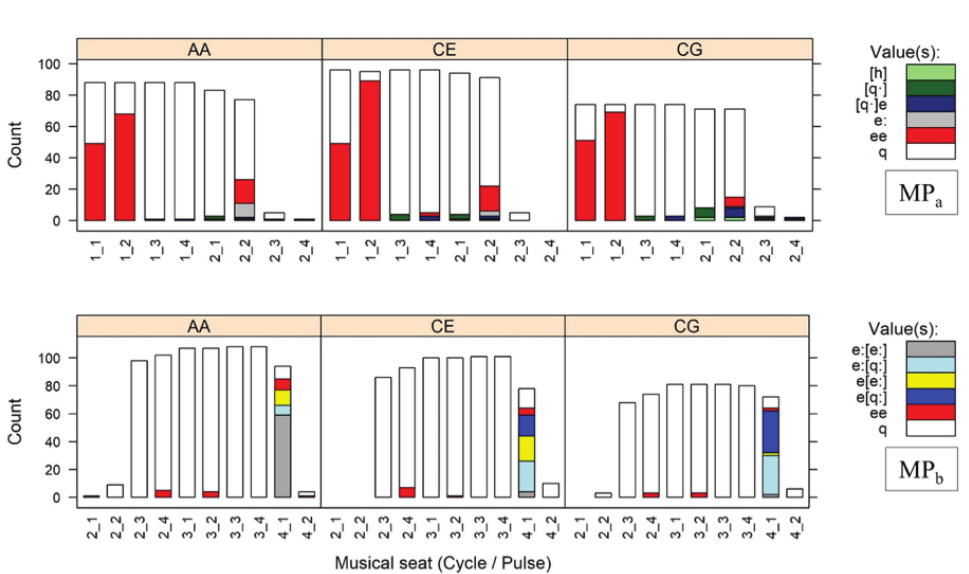
Figure 10: Distribution of rhythmical values per cycle and pulses for each poet. Values exceeding either to the left (i.e. starting in the preceding pulse) or to the right (i.e. ending in the following pulse) are in square brackets ([]). Rhythmic values for MPa are displayed in the top panel, those for MPb in the bottom panel (values with frequency rank > 7 are